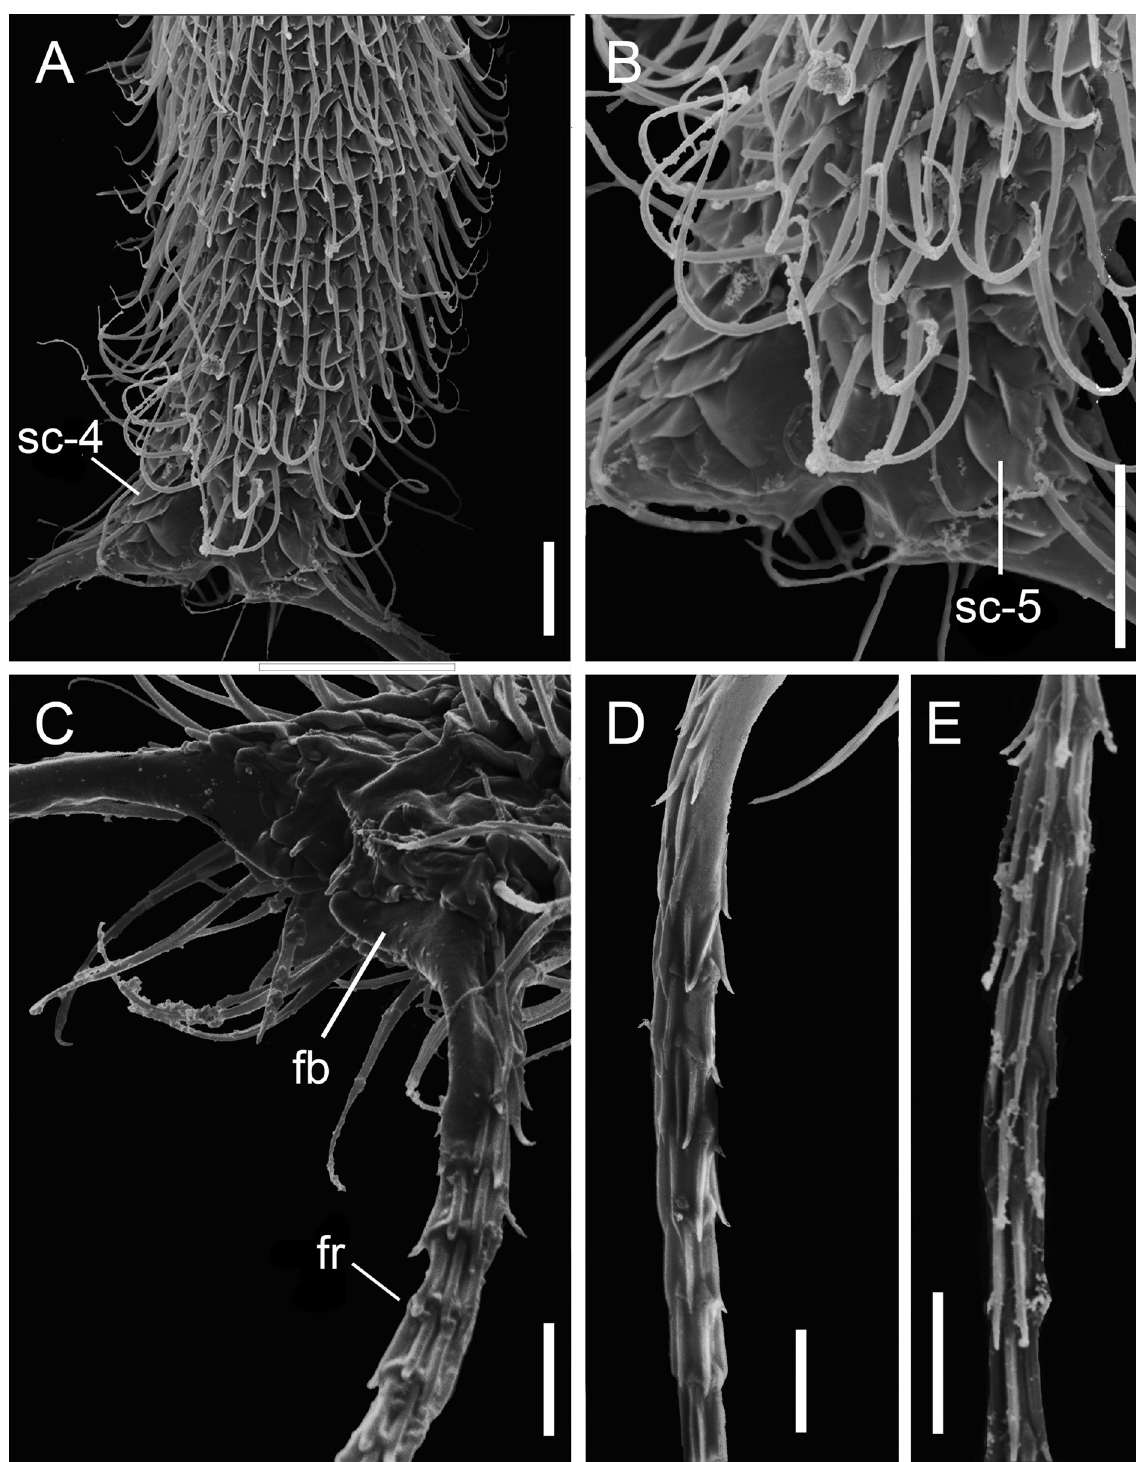
Fig. 8. Scanning electron microscopy. Polymerurus insularis sp. nov. A–B, D . Paratype (ZUEC GCH 59). C, E . Paratype (ZUEC GCH 60). A–B . Posterior dorsal view. C . Detail of the furca base in posterior dorsolateral view. D – E . Details of the furcal rami. Abbreviations: fb = furca base; fr = furcal rami; sc-4 = Type 4 scales; sc-5 = Type 5 scales. Scale bars = 10